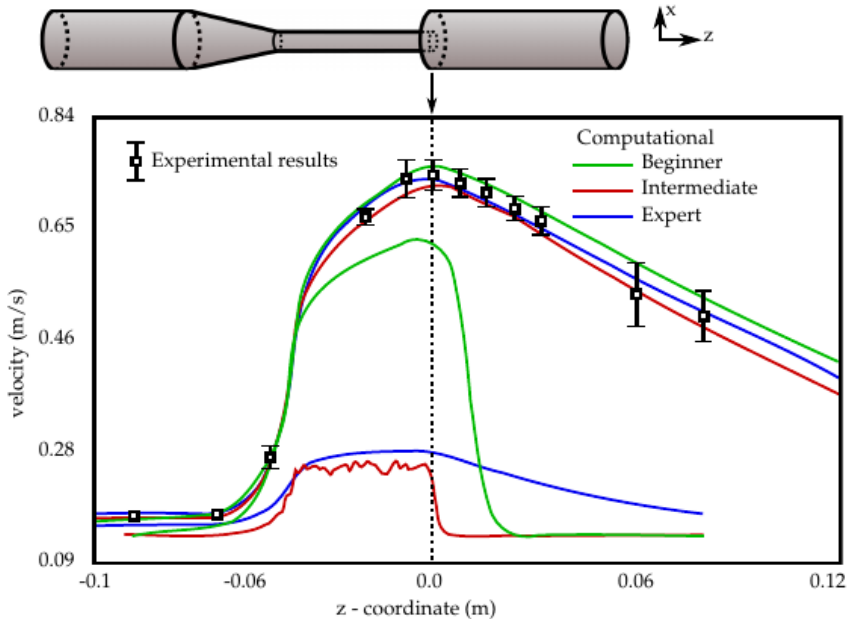
Figure 2. Results from the FDA’s “Critical Path” project to validate computational methods. The best and worst fitting results are shown from each (self-ascribed)